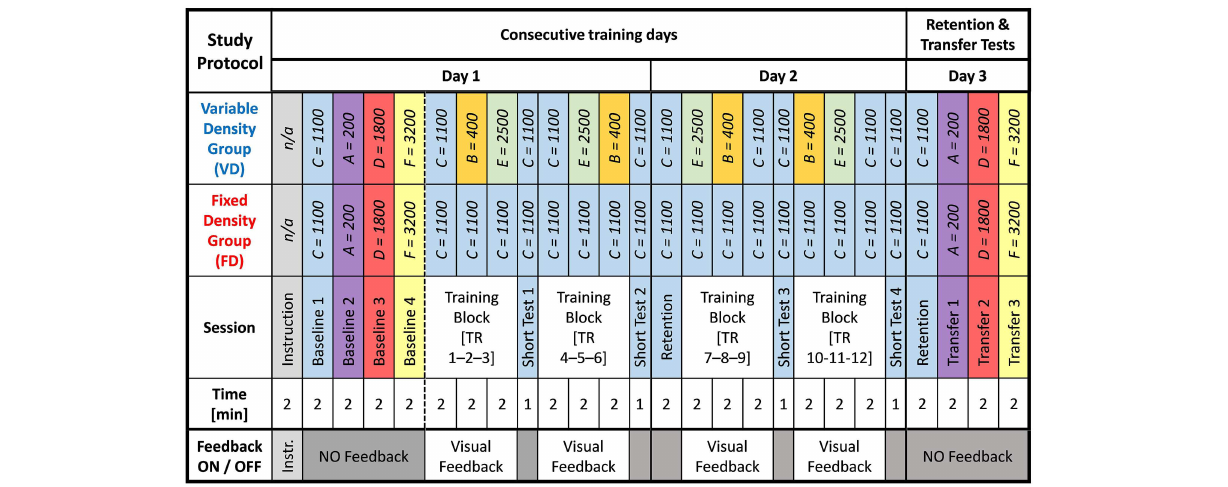
FIGURE 3 | Study protocol showing the groups (VD and FD) and received training methods: The density values that were presented in each training or test session were shown with the corresponding letters, e.g., C = 1100 is ρ = 1100 kg m 3